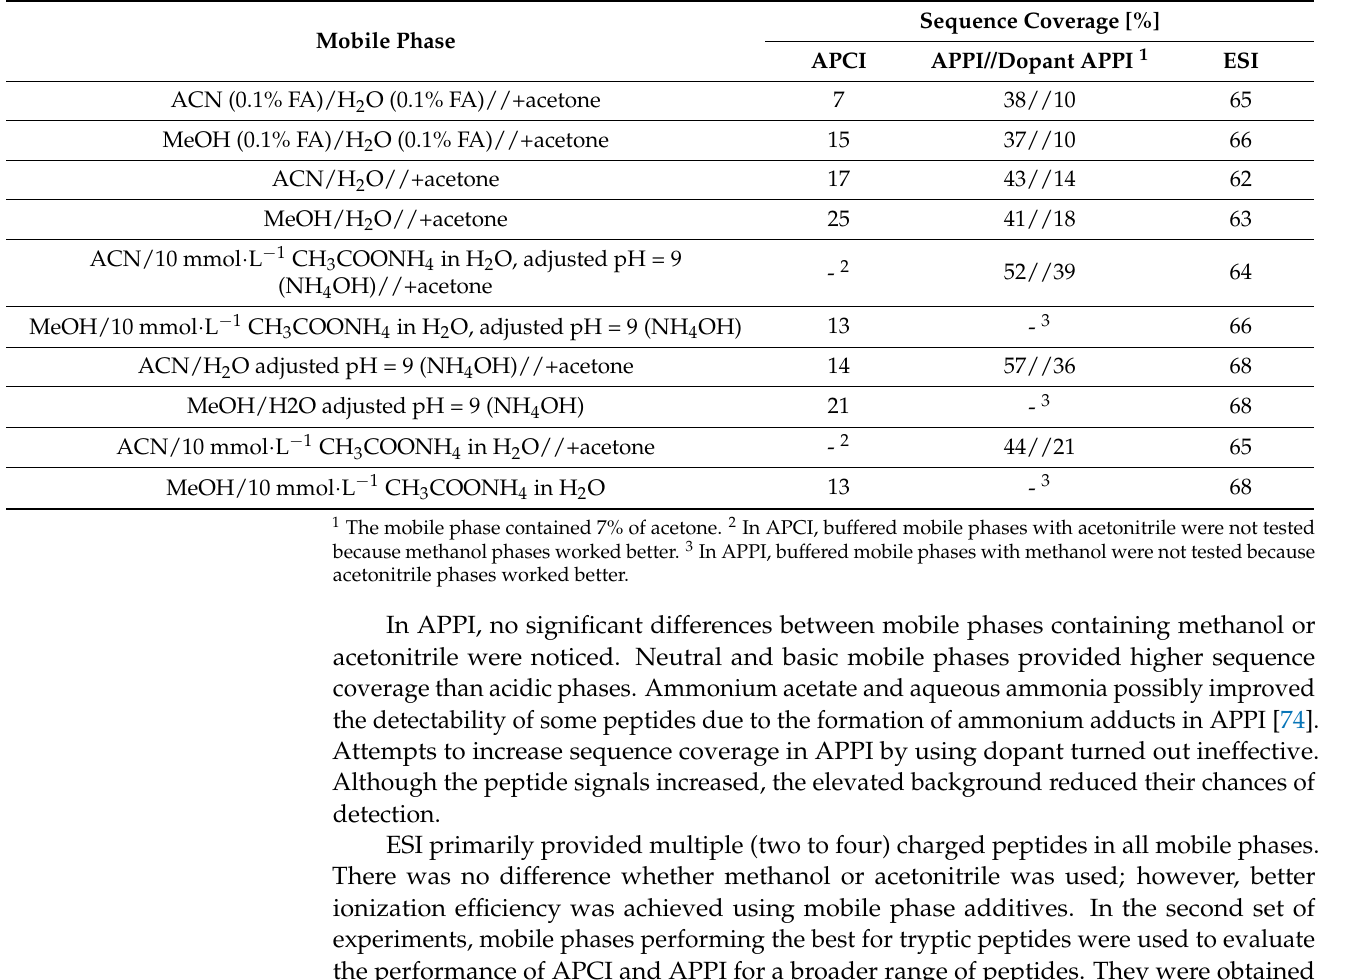
Table 2. Bovine serum albumin (BSA) sequence coverage values for tryptic digest (10 µ L injected; c = 0.65 mmol · L − 1 ) analyzed by APCI, APPI, or ESI using various mobile phases. The peptides were separated at 40 ◦ C by a 25 min gradient elution; the mobile phase flow rate was 225 µ L · min − 1 . Data were evaluated using Amanda and Sequest engines.